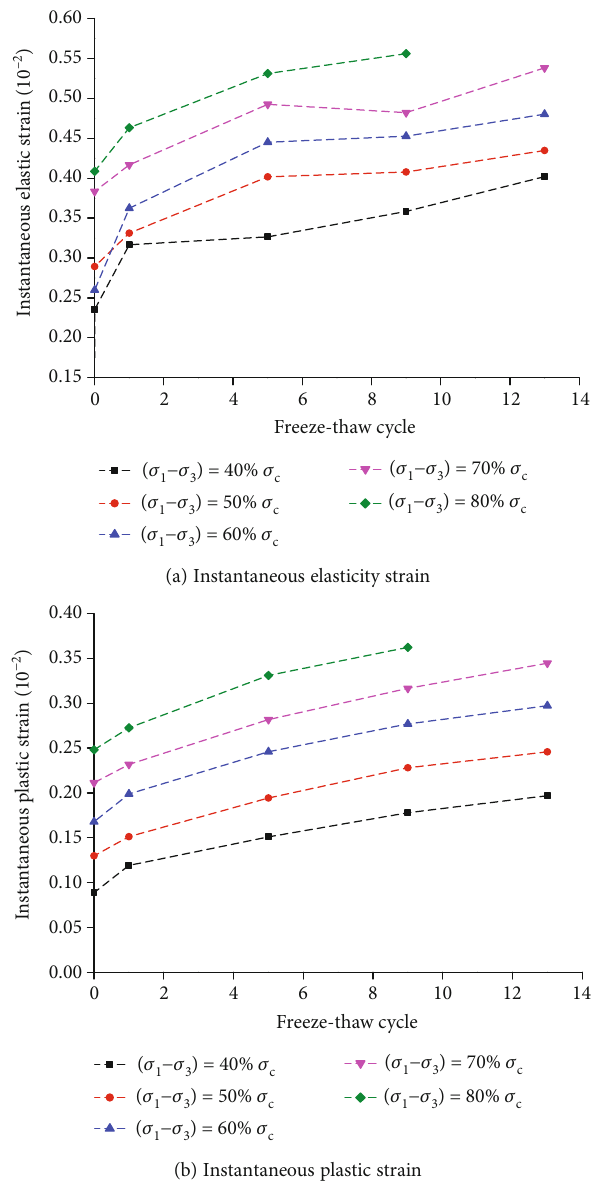
Figure 12: Curves of (a) instantaneous elastic strain and (b) instantaneous plastic strain versus the number of freeze-thaw cycles at various stress levels under 2MPa of con fi ning